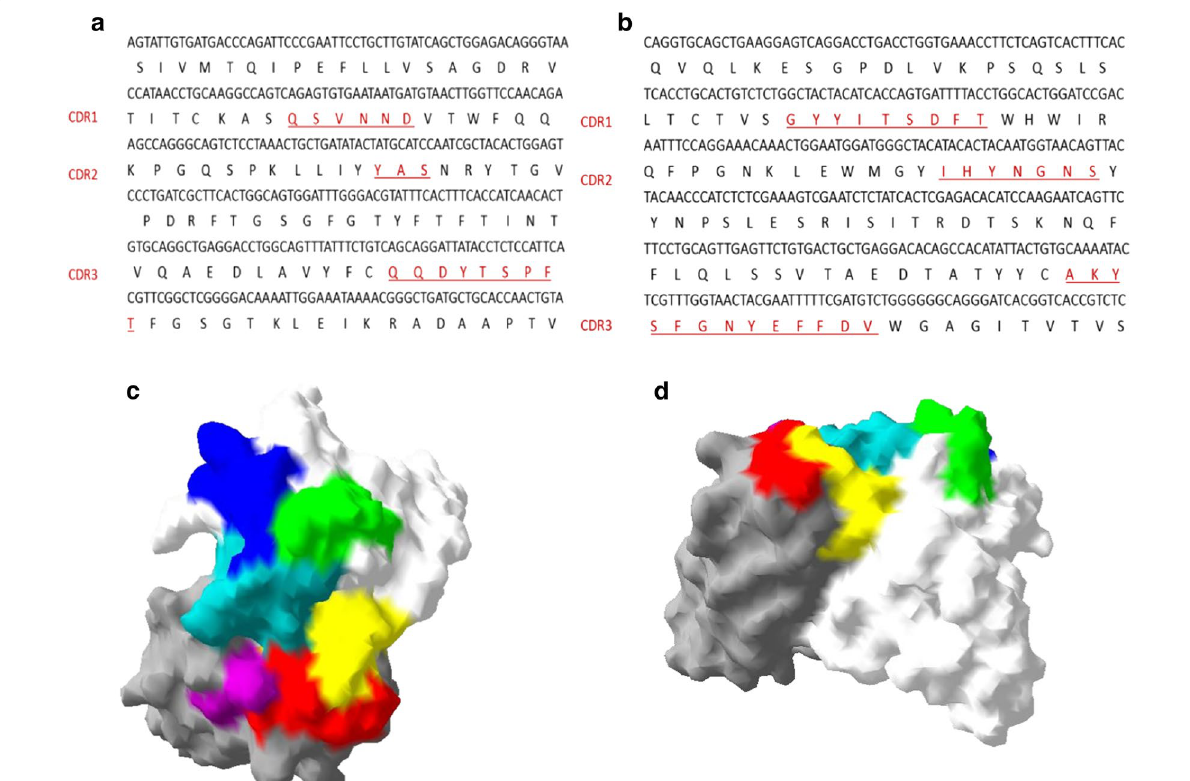
Fig. 1 Sequences of the 1G8 variable region and 3-D structure model of the 1G8 Fab. The variable region sequences of the light chain ( a ) and heavy chain ( b ) are shown with underlined CDRs. The image of the Fab structure was constructed with DeepView software (Swiss PDB Viewer). The model is displayed in top view ( c ) and side view ( d ) with carton and surface rendering. The light chain is shown in white, with CDR1 marked in blue, CDR2 marked in cyan and CDR3 marked in green. The heavy chain is shown in grey, with CDR1 marked in red, CDR2 marked with purple and CDR3 marked with